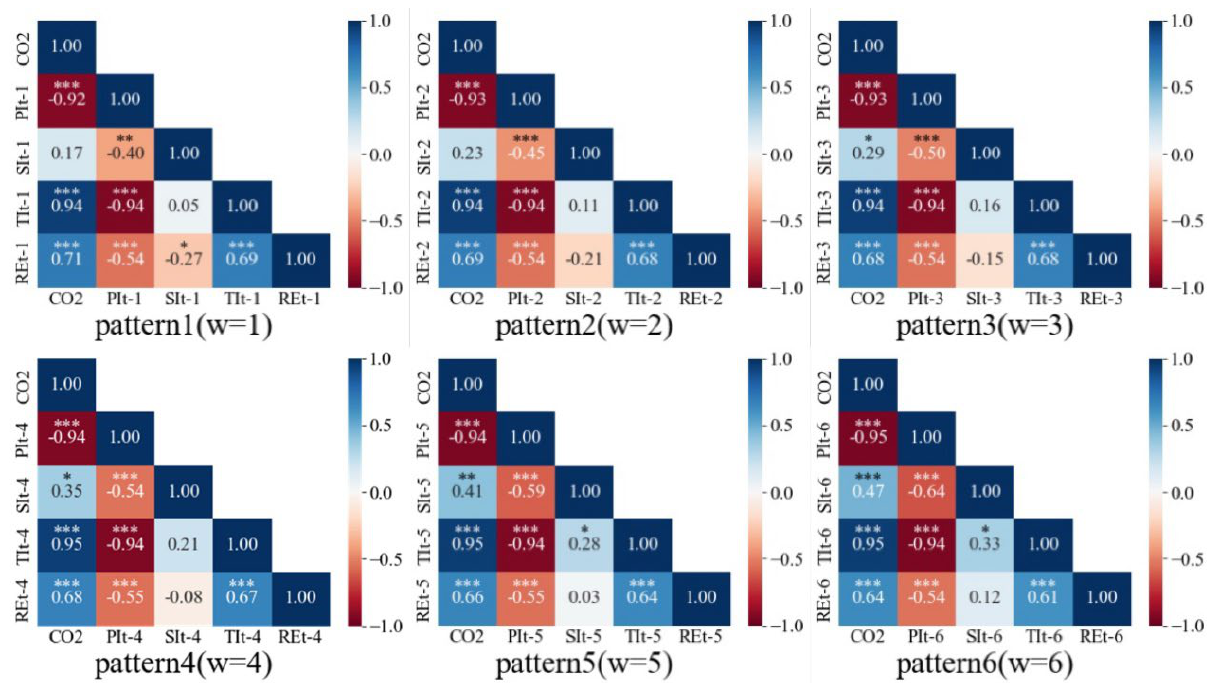
Figure 5. Pearson correlation coefficient of CO 2 emissions and input variables for six window widths. *, ** and *** reflect the significant level of 5%, 1% and 0.1%.